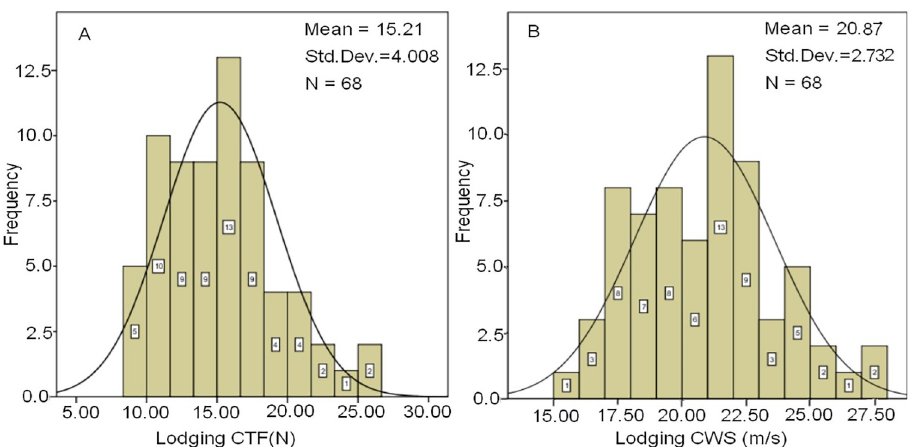
Fig 7. The lodging resistance distribution of common winter wheat varieties in China’s Huanghuai wheat area. A. The lodging CTF distribution of winter wheat population; B. The lodging CWS (instantaneous extreme wind speed) of winter wheat